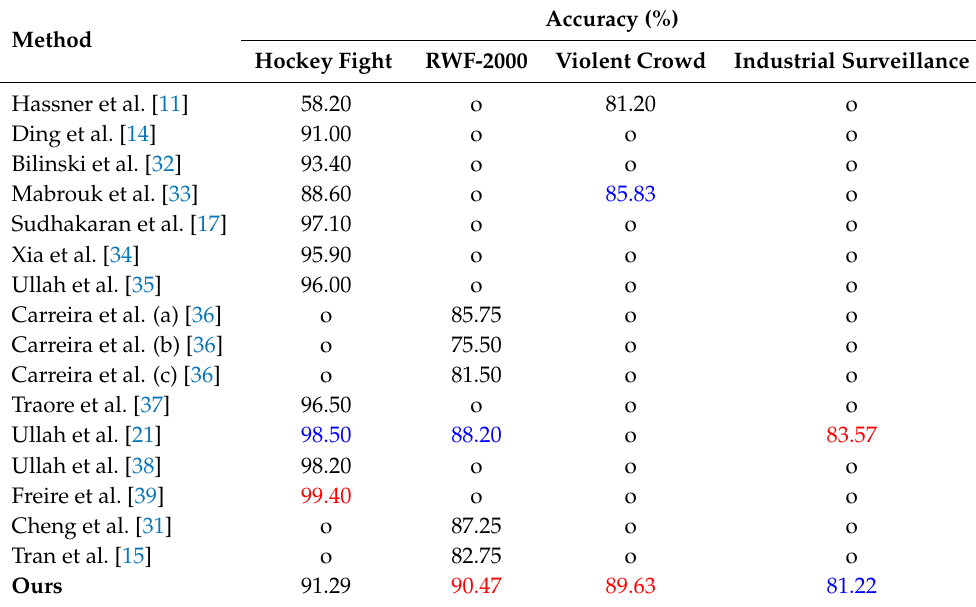
Table 2. Performance evaluation and detailed comparison of the proposed model with the state-of- the-art violence detection techniques (red indicates the best accuracy and blue the second-best results, while o represents Not